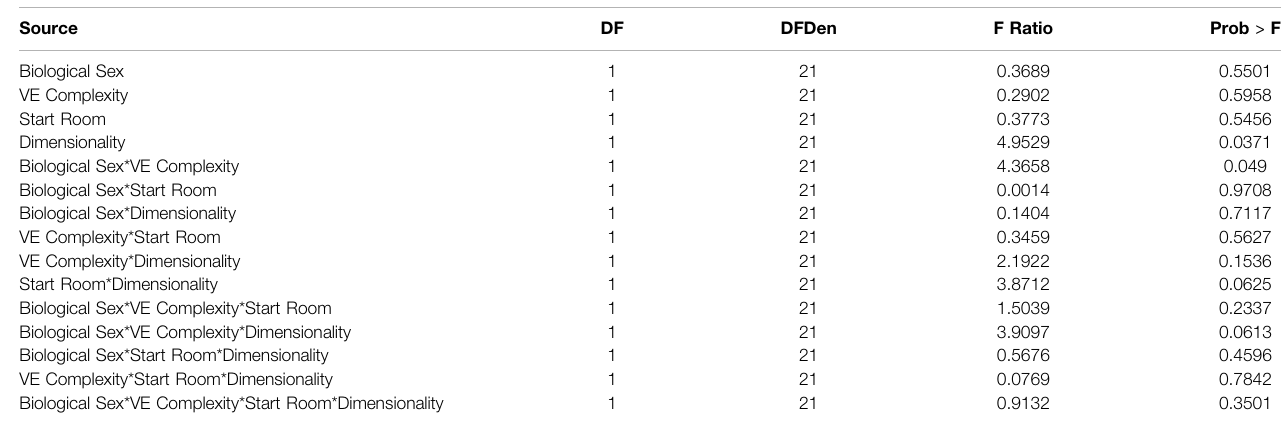
TABLE 4 | IMRT time fi xed effect tests.